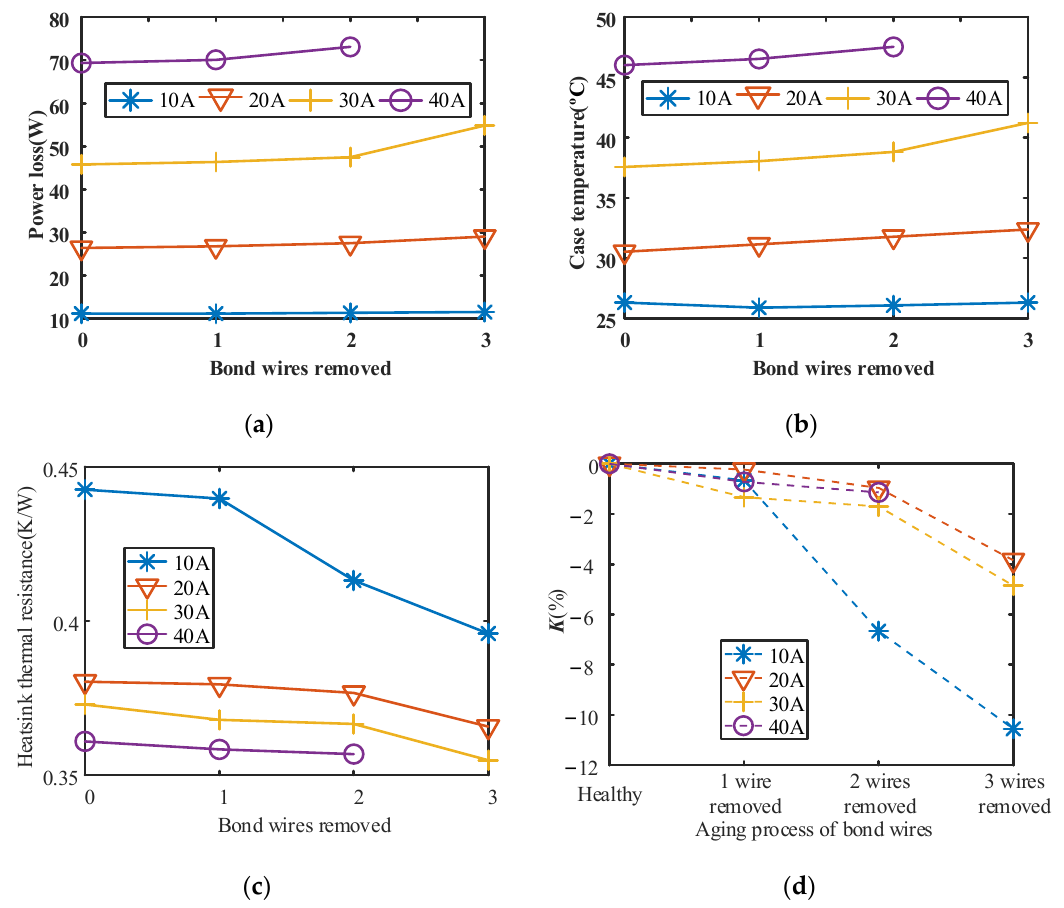
Figure 13. Experimental results: ( a ) power loss of IGBT module; ( b ) case temperature; ( c ) heatsink thermal resistance Z M _ HS ; ( d ) aging ratio K.